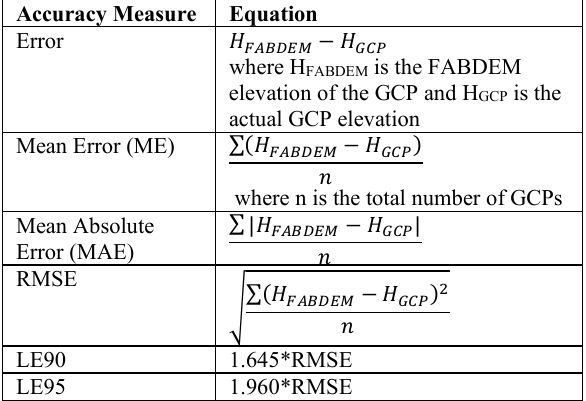
Table 2 . Basic statistics of the EGM2008 elevations of the GCPs (unit: meters).